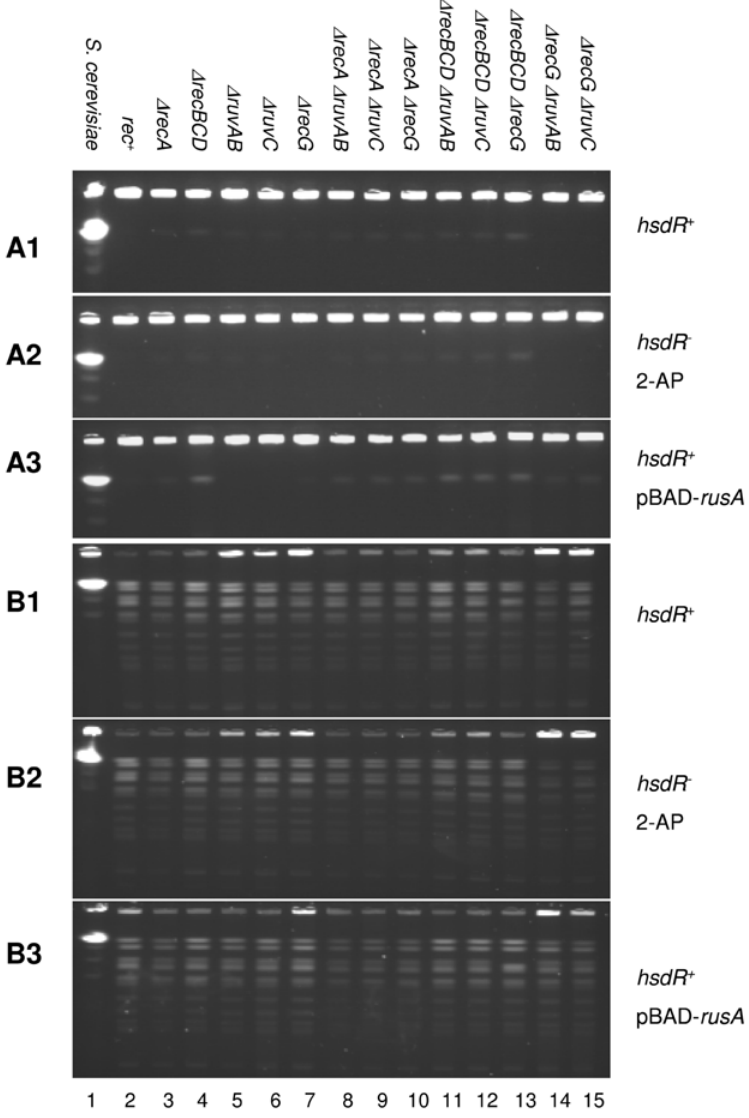
Figure 3. Pulsed field gel analysis of chromosomal DNA of D clpX mutant strains not exposed to EcoKI mediated DNA damage, prior to cleavage with Not I (A1, A2 and A3) and after cleavage with Not I (B1, B2 and B3). The S. cerevisiae chromosomes are shown in lane 1 as a molecular size standard, confirming the compression of linear fragments of 450 kb to 1.5 mb into a single band under the conditions used. This band of yeast chromosomes runs at the same position as linearized E.coli DNA (4.5 mb). (A1 and B1) Lanes 2–15, release of linear DNA into pulsed field gels from rec + and recombination defective strains – all strains are hsdR + and have not been treated with 2-AP: DL1902, DL2656, DL2659, DL3179, DL3184, DL2600, DL3201, DL3207, DL2670, DL3204, DL3208, DL2673, DL3200, DL3206. (A2 and B2) Lanes 2–15, release of linear DNA into pulsed field gels from rec + and recombination defective strains – all strains are hsdR 2 and have been treated with 2-AP: DL1800, DL2666, DL2675, DL3178, DL3180, DL2601, DL3203, DL3211, DL2671, DL3205, DL3210, DL2674, DL3202, DL3209. (A3 and B3) Lanes 2–15, release of linear DNA into pulsed field gels from rec + and recombination defective strains containing the plasmid pBAD- rusA – all strains are hsdR + and have not been treated with 2- AP: DL3122, DL3217, DL3123, DL3218, DL3219, DL3220, DL3221, DL3222, DL3223, DL3224, DL3225, DL3226, DL3227, DL3228.